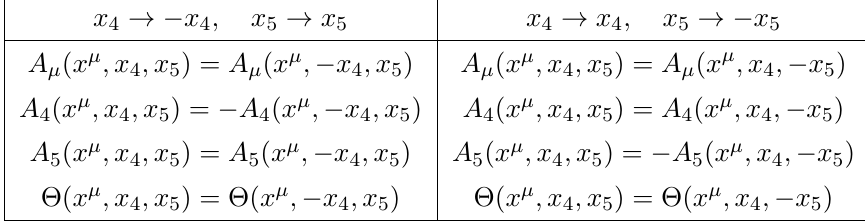
Table 1 . Boundary conditions for the gauge